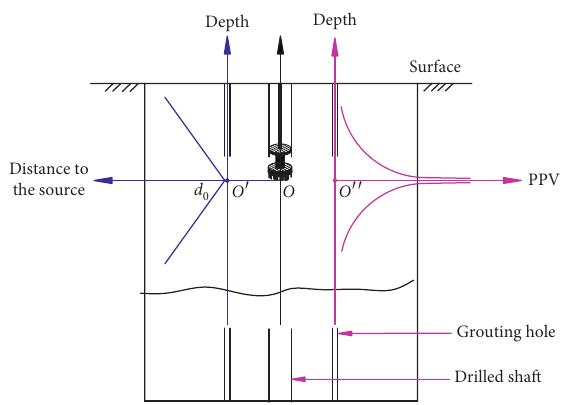
Figure 4: The vibration induced by shaft